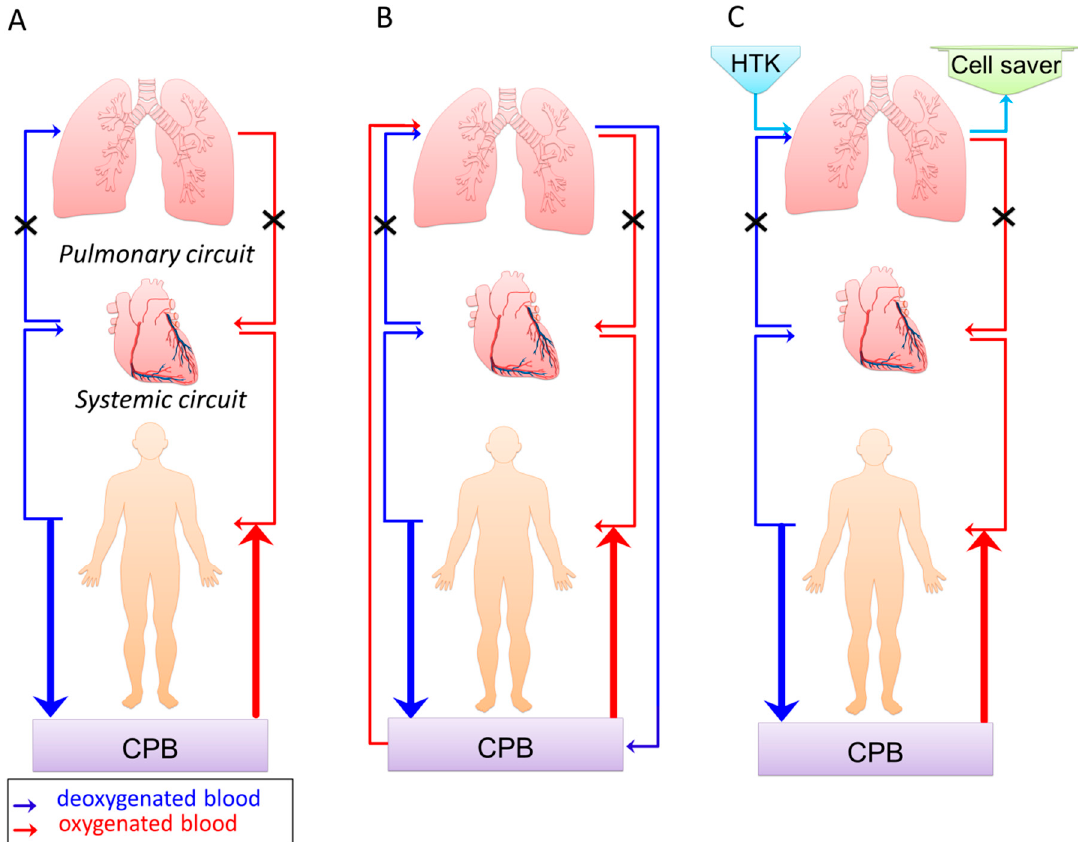
Figure 1. Description of the three interventions: ( a ) standard cardiopulmonary bypass (CPB) without perfusion of the pulmonary circuit; ( b ) CPB plus continuous pulmonary artery perfusion with normothermic oxygenated blood (400 mL/min); ( c ) CPB plus pulmonary artery perfusion with a single-shot of histidine-tryptophan-ketoglutarate (HTK) solution (2000 mL). The volume returning to the left atrium from the pulmonary circuit was filtered by a cell saver, only returning the red blood cells to the heart and lung machine’s venous reservoir. At the end of CPB, reperfusion of the pulmonary circuit added approximately 500 mL HTK solution to the systemic circuit.